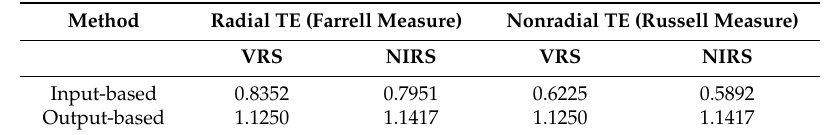
Table 2. Radial and nonradial measure of technical e ffi ciency (TE) using the data envelopment analysis (DEA) approach under VRS and NIRS assumption.